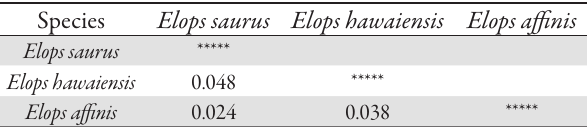
Tab. 4. K2P genetic distance between Elops species based on